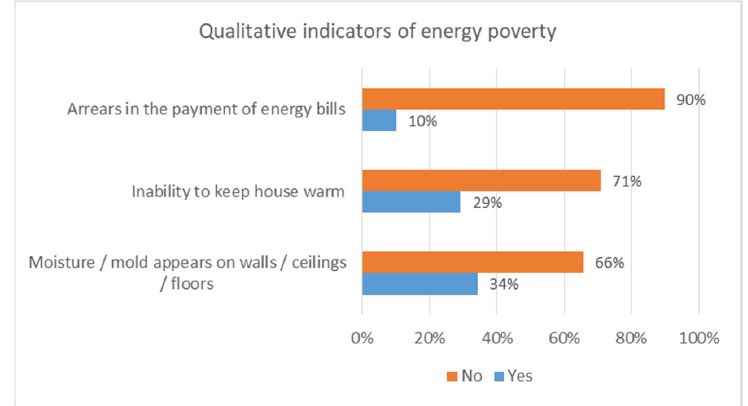
Figure 3. Energy poverty qualitative indicators in Metsovo.